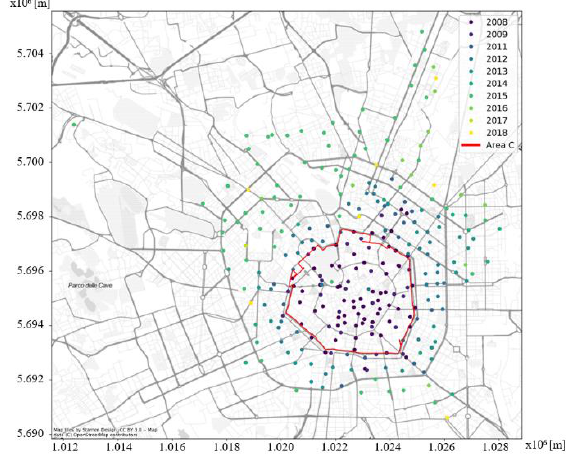
Figure 1. BikeMi BSS - stations installation year. (EPSG:3857)